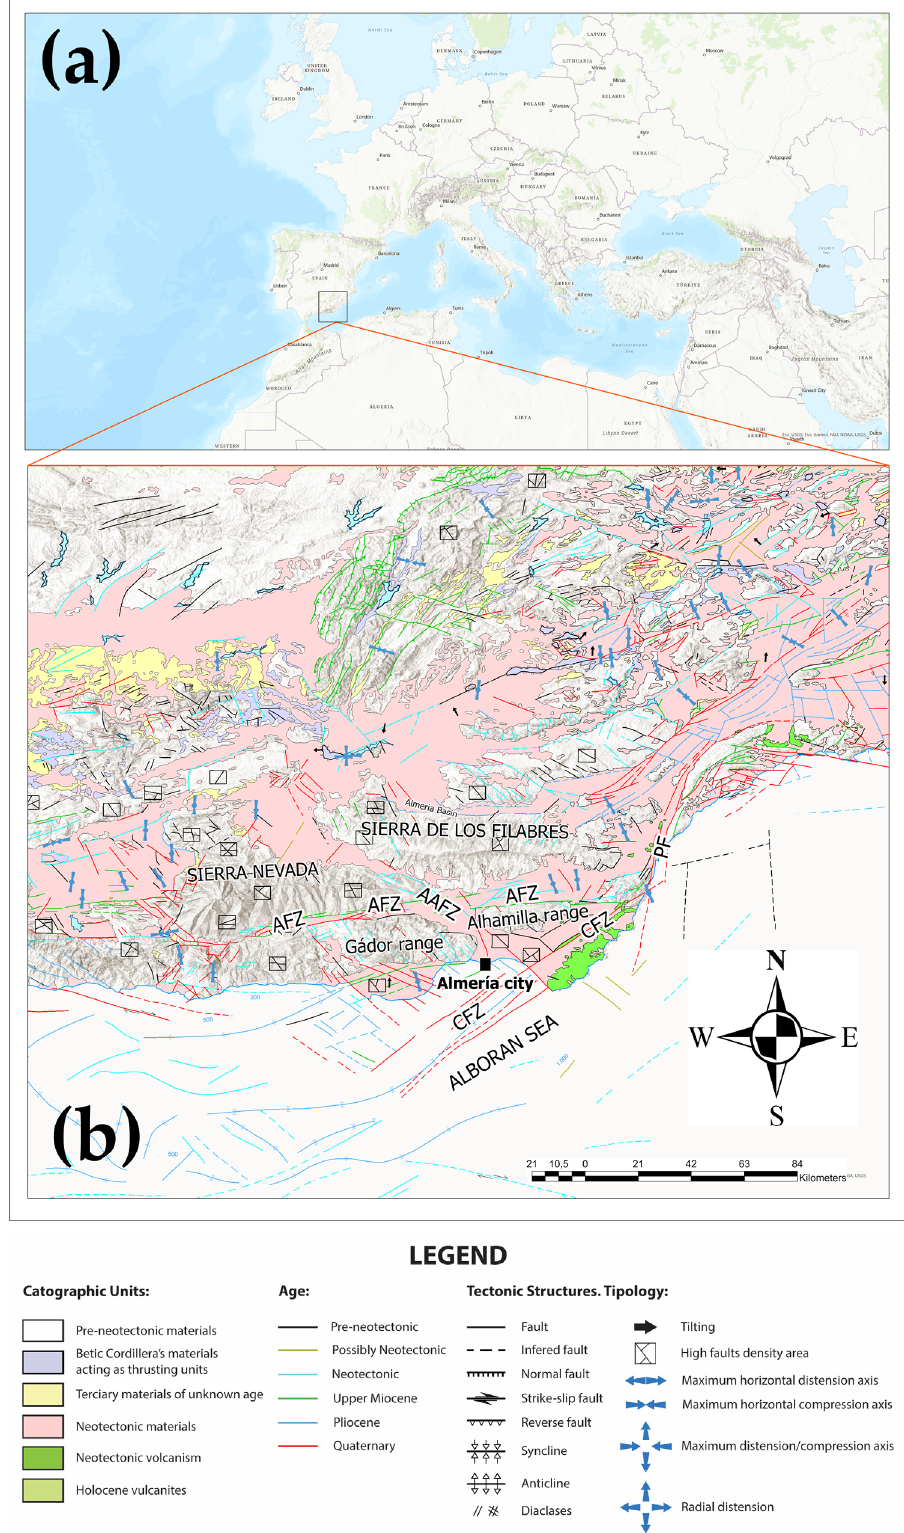
Figure 1. ( a ) Geographical location of Almeria city; ( b ) structural map of the southeastern Betic Cordillera (Spain).